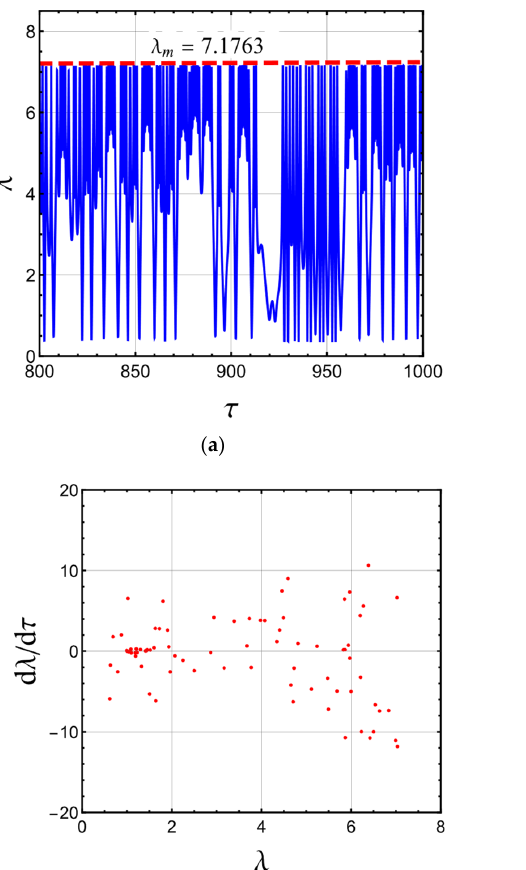
( d ) Figure 7. The dynamic response of the electro ‐ magneto ‐ active polymer to time ‐ varying voltage 𝐻(cid:3365) (cid:3404) 𝐻(cid:3365) (cid:2903) (cid:3404) 0.4 and 𝐾 (cid:3404) 0.3 . ( a ) Time history, ( b ) phase plane diagram, ( c ) Poincaré map, and ( d ) FFT.